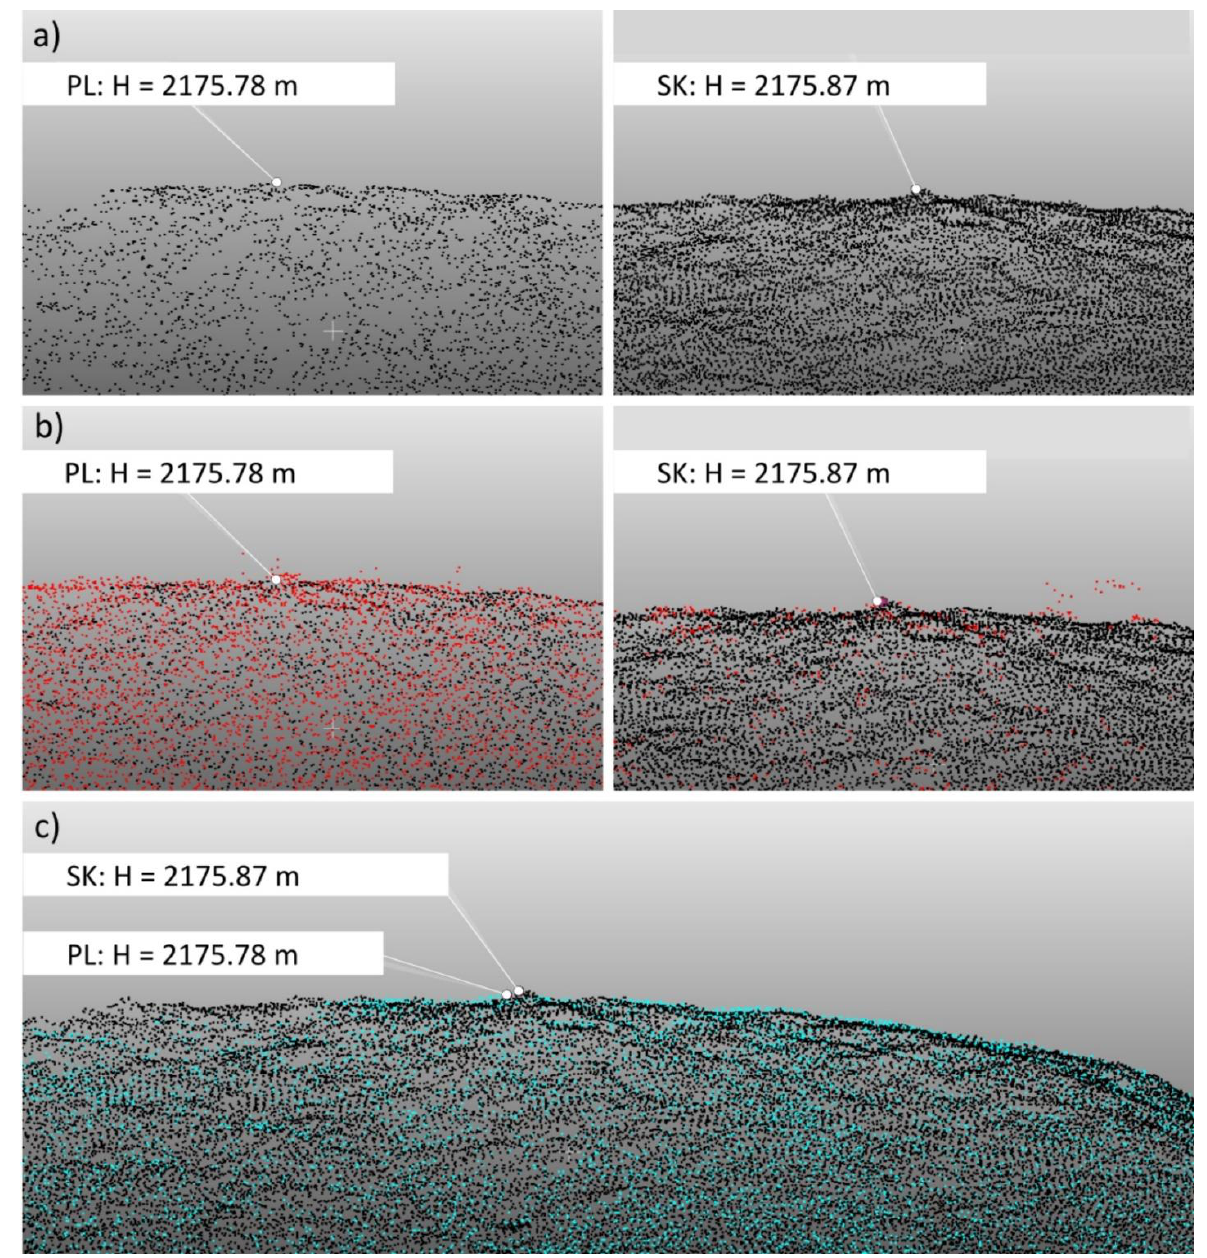
Figure 5. ( a ) The highest point on Starorobociański Wiech and Ground class, ( b ) the highest point at the peak and all other classes (black—Ground, red—others), ( c ) Polish (blue) and Slovak (black) datasets, Ground class. Source: authors.